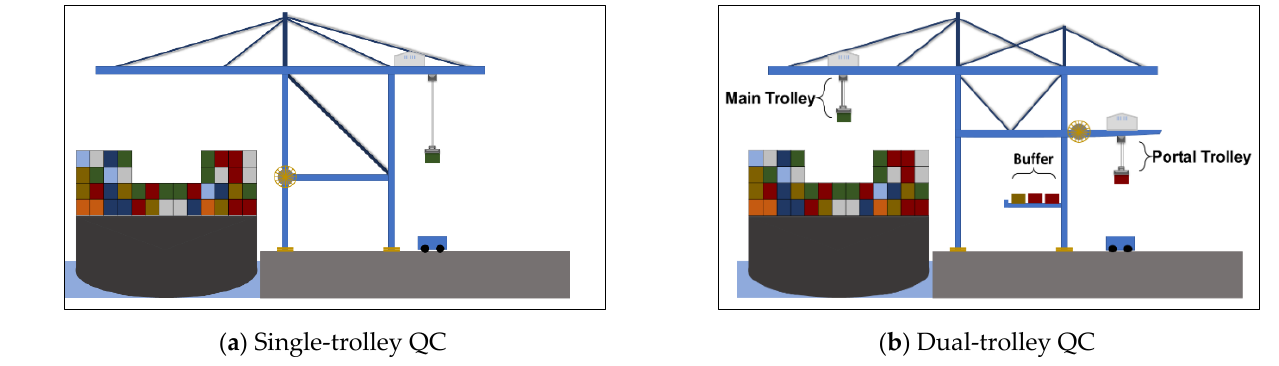
Figure 1. Types of QCs in ACTs ( a , b ) .